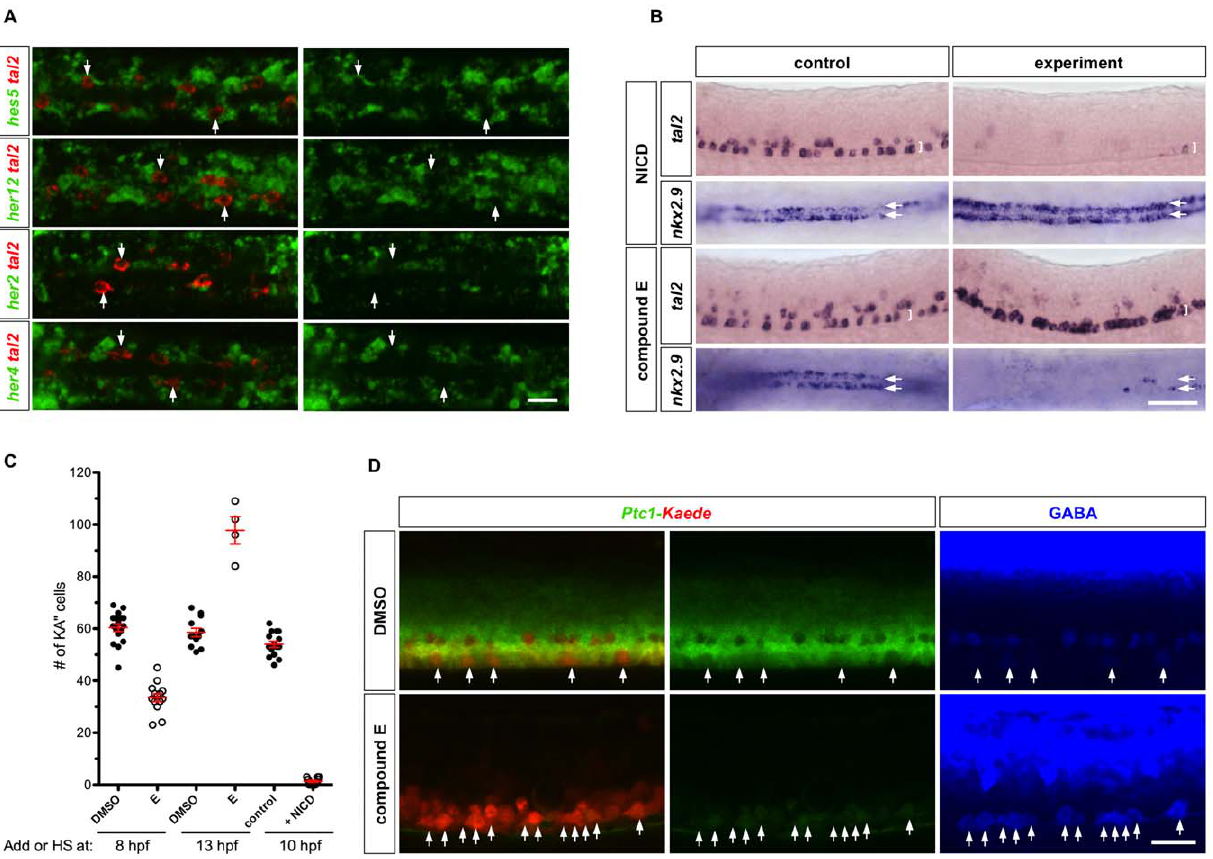
Figure 6. Notch signaling in KA 0 specification. (A) Wild type embryos at 18 hpf were double labeled with tal2 (red) and hes5 , her12 , her2 , or her4 (green). tal2 -expressing KA 0 cells (arrows) lack expression of hes5 , her12 , her2 , or her4 . Note that hes5 , her12 , her2 , and her4 are expressed in only a subset of LFP cells, which might reflect the oscillating nature of these genes in neural progenitor cells as previously reported [49]. Dorsal views are shown. (B) hsp-Gal4; UAS-NICD embryos and non-transgenic control embryos were heat-shocked at 10 hpf, and stained at 25 hpf for the expression of tal2 and nkx2.9 (top panel). Embryos were treated with DMSO or compound E at 13 hpf, and stained at 25 hpf for the expression of tal2 and nkx2.9 (bottom panel). tal2 and nkx2.9 staining is shown in lateral and dorsal views, respectively. Brackets indicate the extent of the LFP domain in lateral views, and arrows denote the two rows of LFP domains in dorsal views. (C) Quantification of KA 0 specification under different conditions. KA 0 cells were scored by the expression of tal2 at 25 hpf. Note that the fewer data points in compound E treatment at 13 hpf is due to the fact that most compound E-treated embryos had many tal2 -positive cells in close clusters which prevents reliable scoring. Data shown therefore underestimate the total number of KA 0 cells under this condition. (D) Ptc1-Kaede embryos were treated with DMSO or compound E at 14 hpf, photoconverted at 25 hpf, and stained with the GABA antibody (blue) at 37 hpf. Compound E treatment induced ectopic GABA-positive cells in the LFP domain (arrows), and abolished the expression of Ptc1-Kaede green (middle panel). Scale bars: 20 m m in A, D and 50 m m in